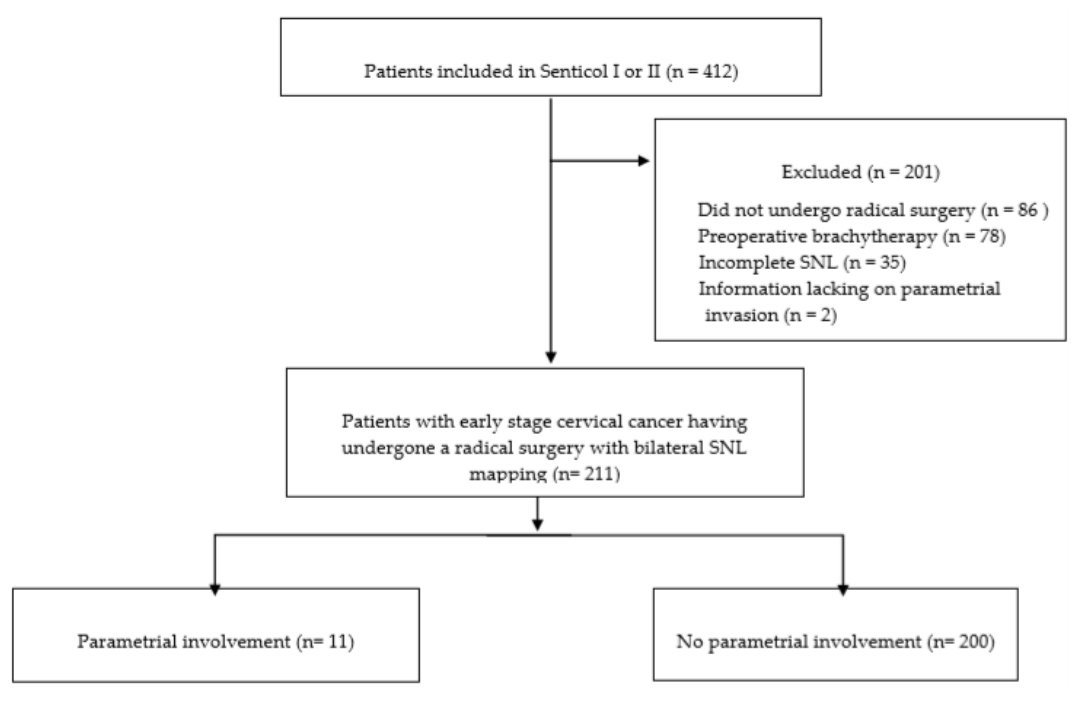
Figure 1. Flow Figure 1. Flow chart.